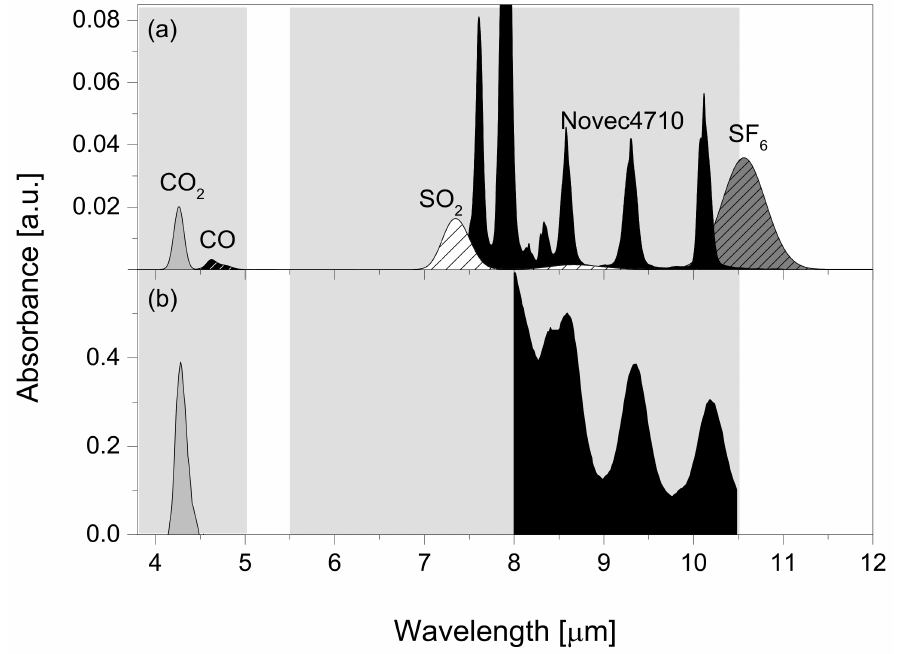
Figure 4. Wavelength tuning range of the detector and simulated absorption spectra. ( a ) Typical spectra of Novec-4710, CO, CO 2 , SO 2 , and SF 6 detectable within the wavelength scan range of the spectrometer. The simulated spectra of CO, CO 2 , SO 2 , and SF 6 were based on the HITRAN database. The simulation conditions were as follows: concentration of 50 ppmv, OPL of 10.5 m, cell injection pressure of 50 Torr, and resolution of 50 cm − 1 . The Novec-4710 spectrum was measured using an FTIR spectrometer, and the measurement conditions were as follows: resolution of 0.5 cm − 1 and the same concentration, OPL, and cell injection pressure as the simulation conditions. ( b ) CO 2 and Novec-4710 spectra measured while scanning the wavelength of the tunable filter. CO 2 with concentration of 58.2% and Novec-4710 with concentration of 5.0% were injected into the SP cell with an OPL of 5 cm under an injection pressure of 100 Torr. Wavelength scanning was performed from 3.8 µ m to 10.5 µ